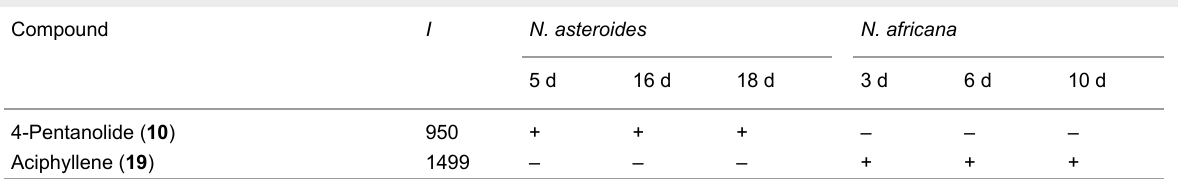
Table 3: Compounds released by Nocardia spp. grown on a 7H11 solid medium. a